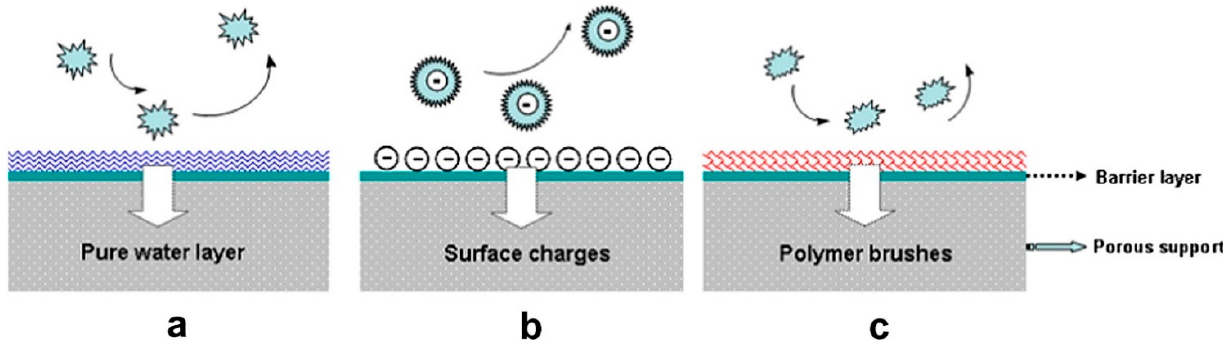
Figure 2. Schematic representation of various antifouling mechanisms with composite membranes: ( a ) thin layer of bounded water, ( b ) electrostatic repulsion, and ( c ) steric repulsion (adapted with permission from [39]).